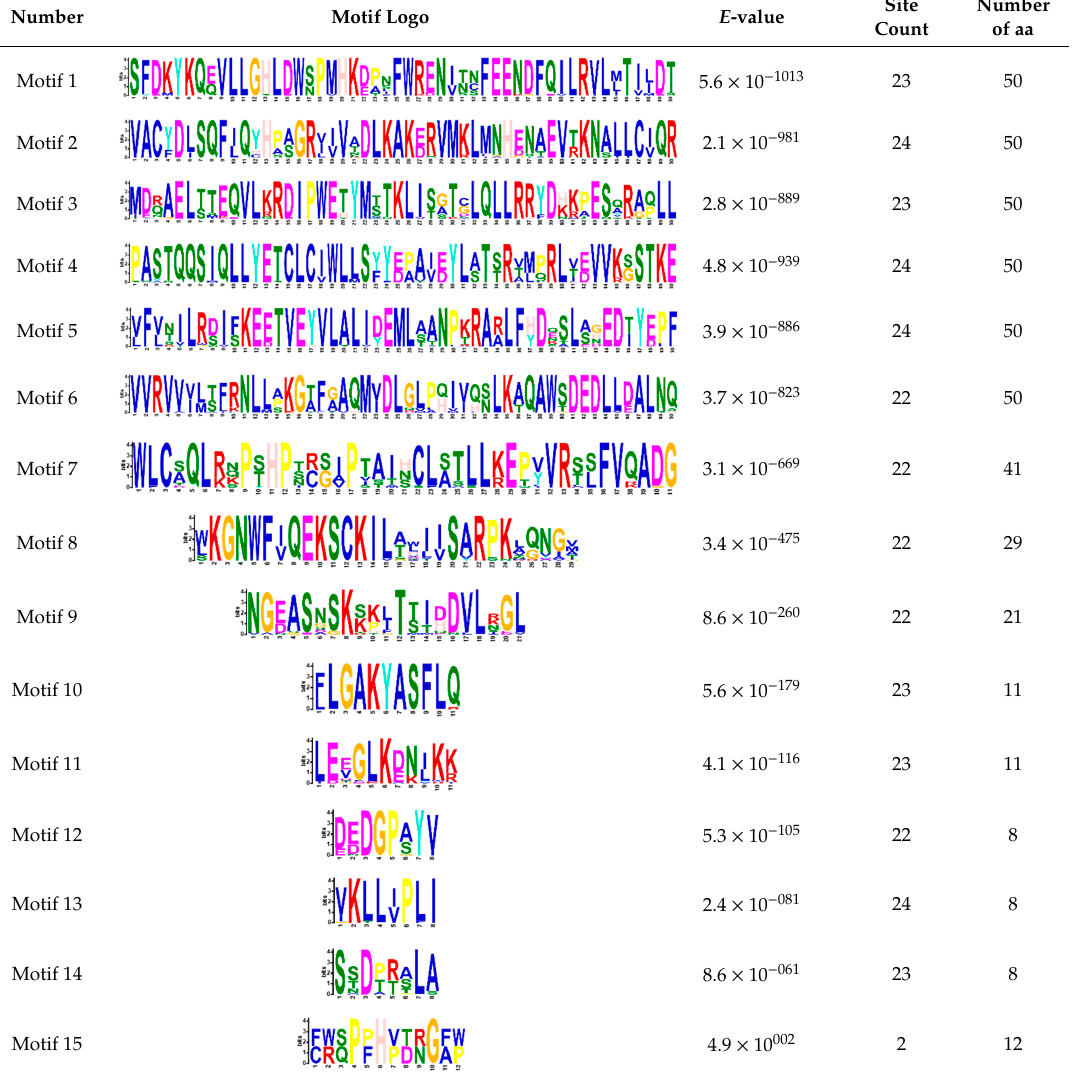
Table 2. The amino acid compositions of the 15 motifs of the 24 VHA-H genes revealed by MEME. The relative height of each letter (standing for an amino acid) is proportional to the relative entropy of the corresponding amino acid at the given position. Amino acids are listed in the descending order of frequencies from top to bottom within each position. Site Count represents the number of species with a motif detected.